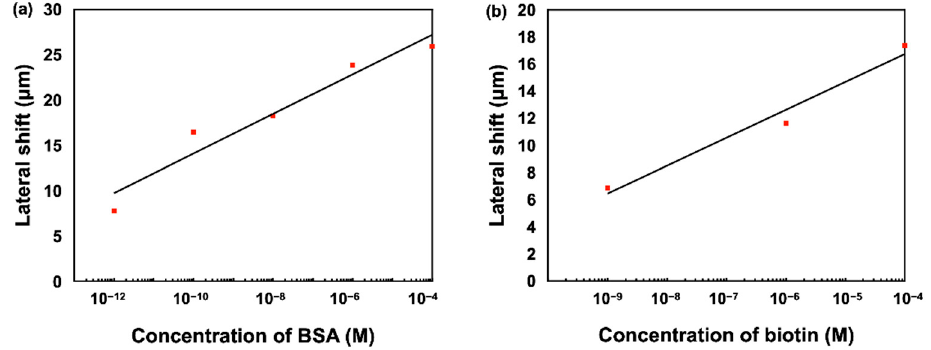
Figure 9. Real-time detection of biotin molecules based on lateral position shift measurement.